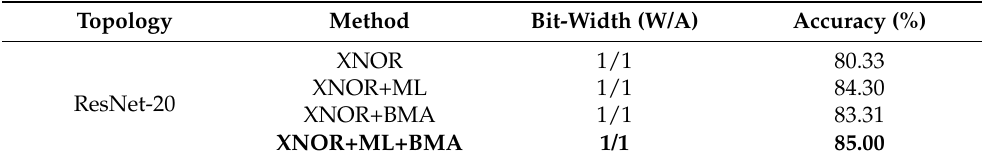
Figure 6. ( a ) Validation accuracy curves and ( b ) Training loss curves during the training process. Baselined IR-Net/Bireal18, improved three schemes with BMA, ML, and both BMA+ML are evalu- ated and illustrated. All cases are with λ = 10 − 4 .